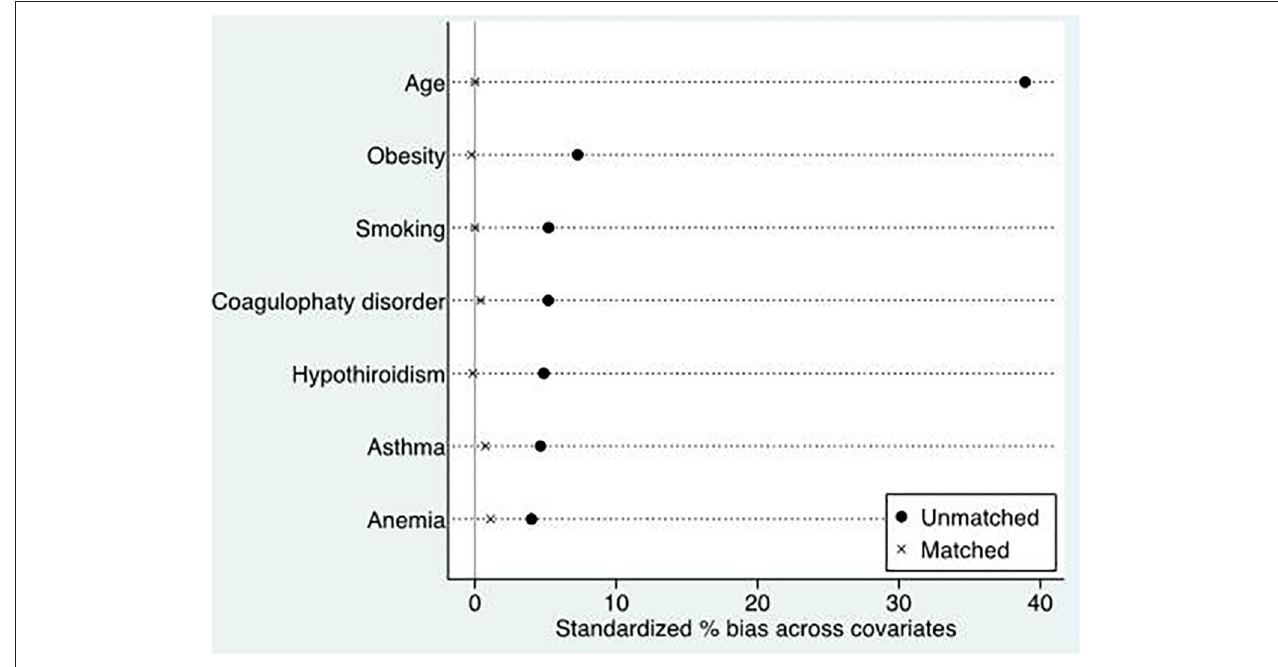
FIGURE 2 | Propensity score matching of women with and without varicose veins (LEPVI).